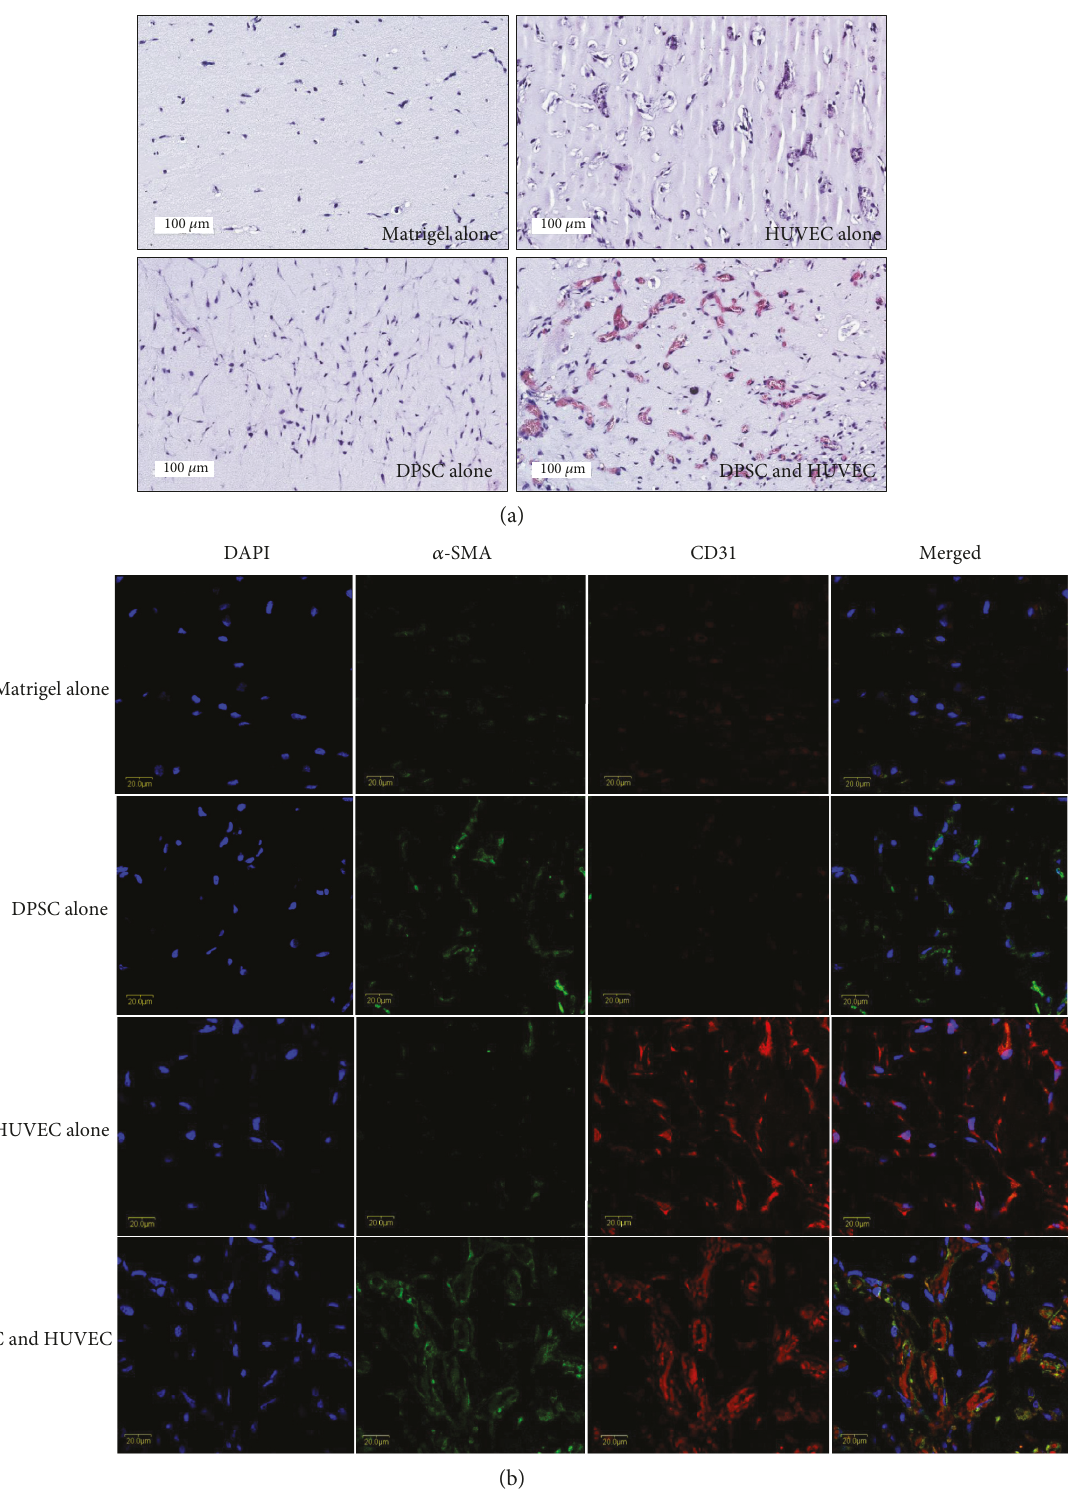
Figure 3: In vivo angiogenic potential of DPSCs. To investigate in vivo angiogenic potential of DPSCs, Matrigel plug assay was conducted. DPSCs and HUVECs were subcutaneously injected and separated or together into immunode fi cient mice. At 7 days postinjection, Matrigel plug was removed and analyzed by H&E and immuno fl uorescent stainings. (a) In the results of DPSCs alone or HUVEC alone, no obvious microvessel-like structures were observed. However, when DPSCs and HUVECs were coinjected, microvessel-like structures were formed and red blood cells were observed in the lumen. (b) Immuno fl uorescent staining by CD31 and α -SMA showed that microvessel-like structures were stained on coinjection with DPSCs and HUVECs